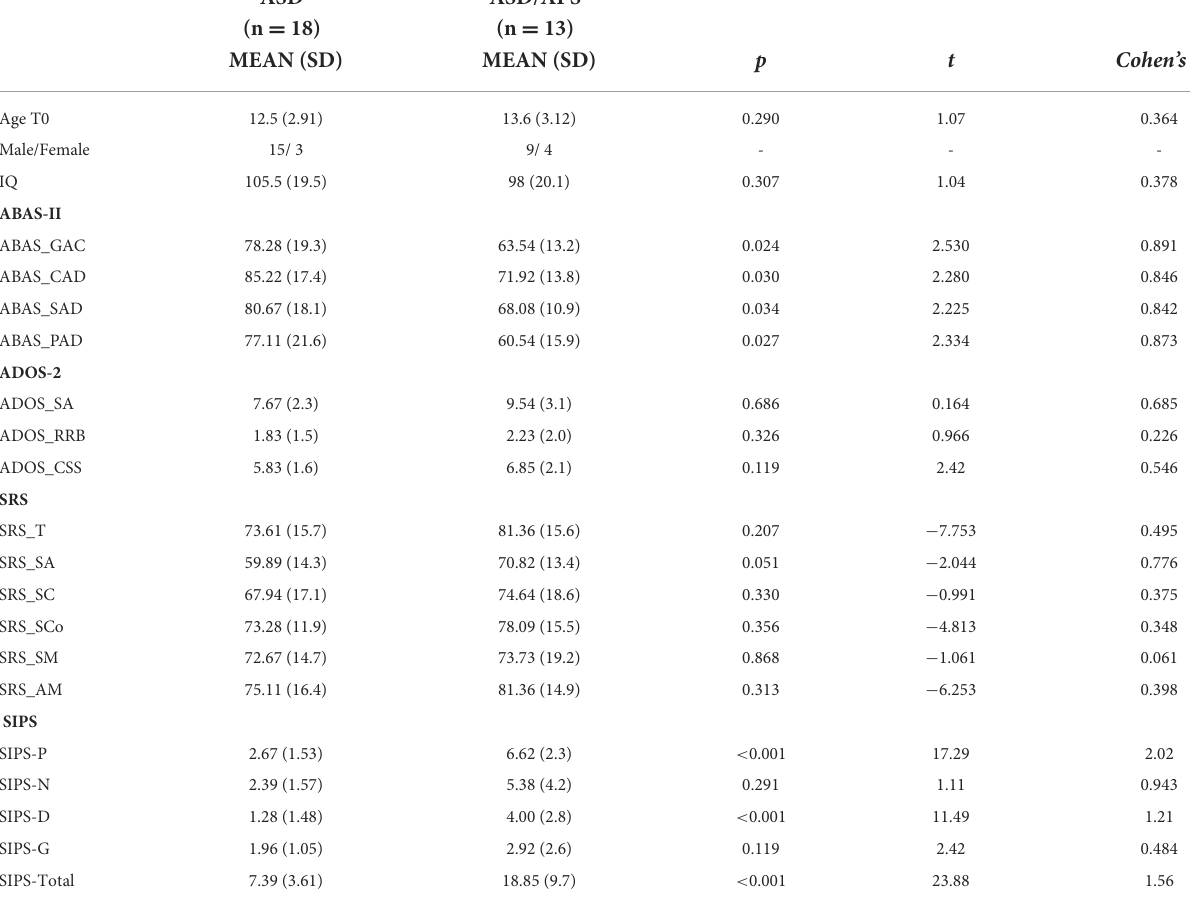
TABLE 1 Baseline clinical characteristics in ASD vs. ASD/APS